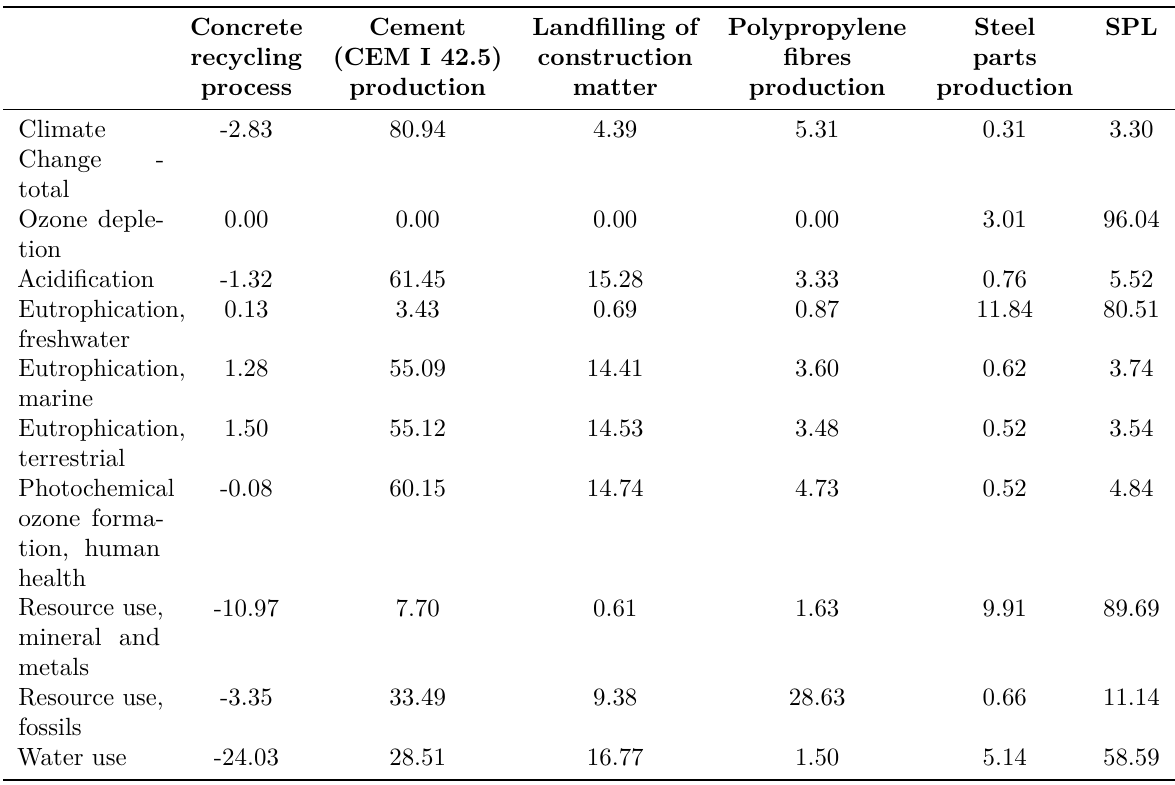
Table 4. The relative contribution of processes (only processes with relative contribution higher than 10 % of total impact in a category are stated), %.